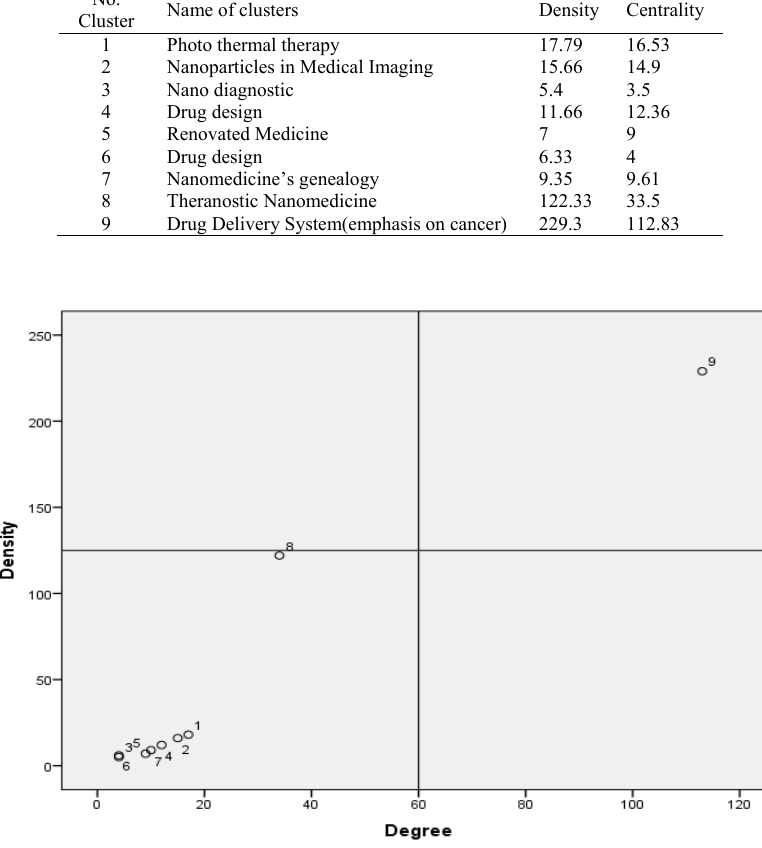
Fig. 4: The strategic diagram of nine Fig 4: The strategic diagram of nine clusters.